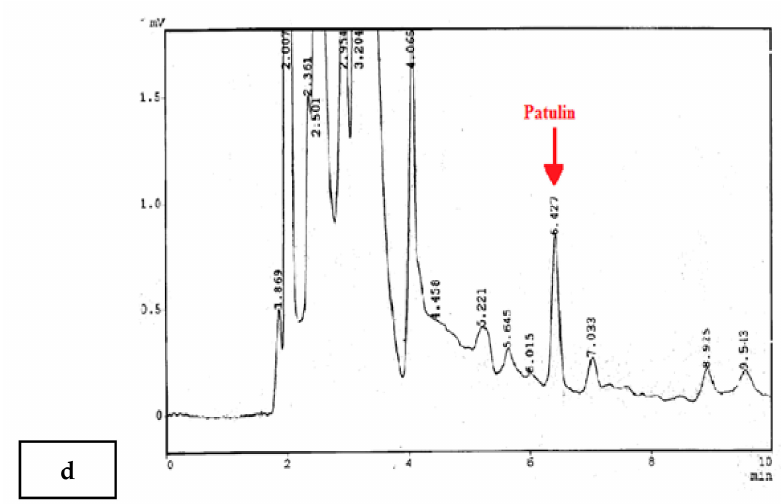
Figure 1. Chromatogram showing the natural occurrence of patulin in orange ( a ), sweet orange ( b ), lime ( c ), and grapefruit ( d